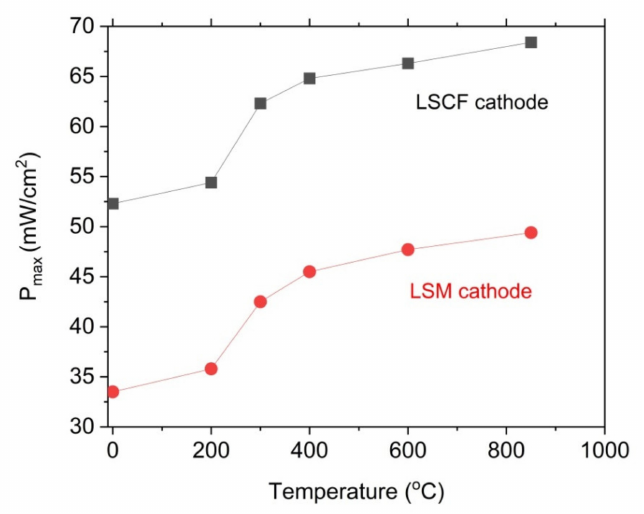
Figure 16. Dependence of maximum P max vs. temperature of solid fuels preparations. P max values were obtained for DC-SOFCs (I) and (II) with LSM or LSCF cathodes, respectively. Data refer to a temperature of 850 ◦ C and experimental conditions that are presented in Figure